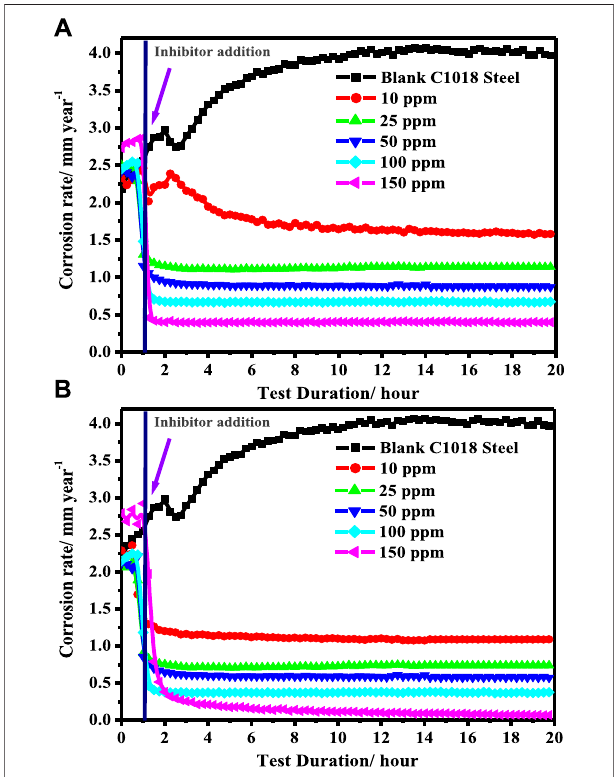
FIGURE6| ChangeofthecorrosionratewithimmersiontimeforC-steel in blank 3.5% NaCl saturated with carbon dioxide and inhibited medium containing a different concentrations of (A) CSM and (B) CSD at 50 ± 1 ° C.